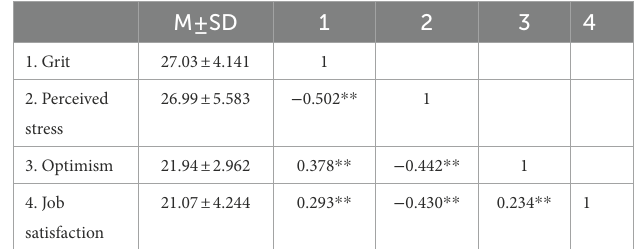
TABLE 1 Sociodemographic information of the participants ( n = 709). TABLE 2 Bivariate